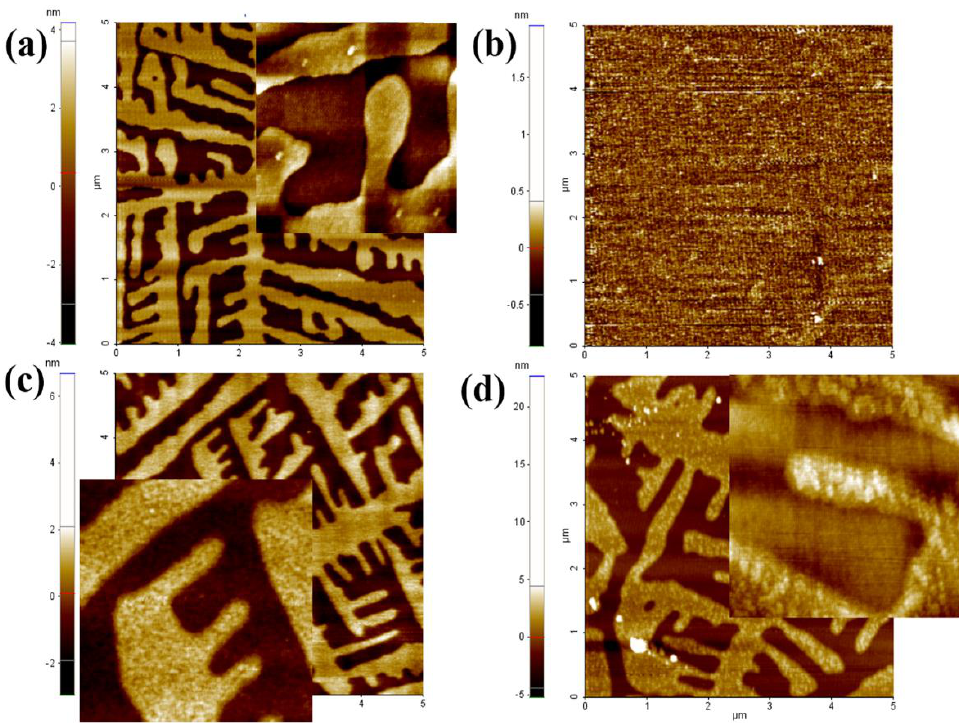
Figure 2. AFM images of C 32 H 66 thin films prepared at the concentration of 0.13% w/v ( a ) as- deposited, ( b ) as-deposited and hexane-washed, ( c ) after hyperthermal hydrogen bombardment cross-linking, and ( d ) after hyperthermal hydrogen bombardment and hexane washing (insets: their higher-resolution images and scanning scale is 1 µ m × 1 µ